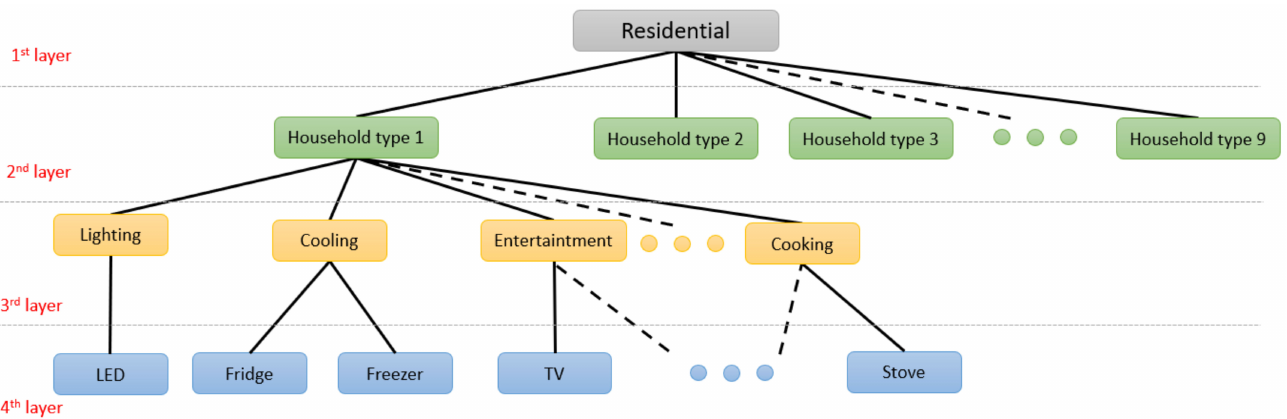
Figure 2. Residential sector sub-structures.